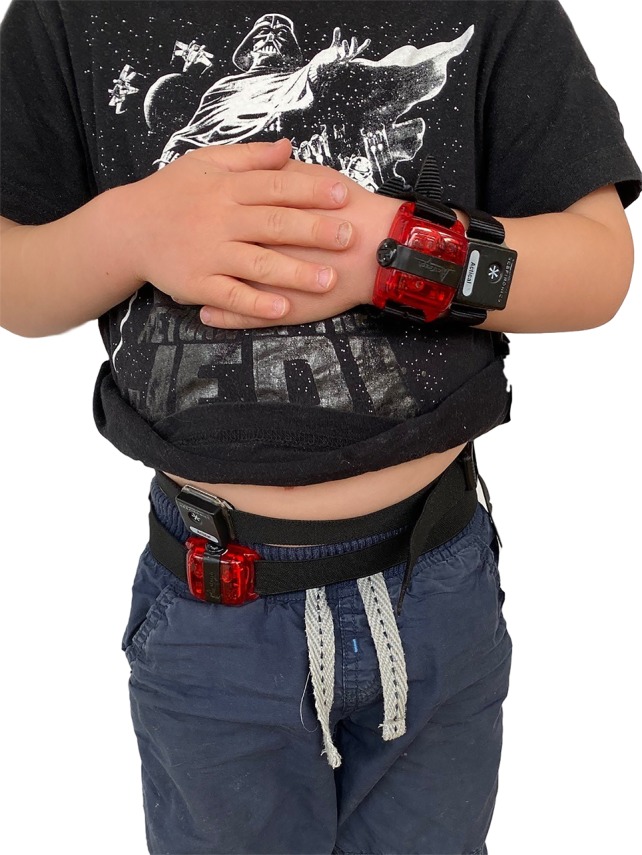
Site placements for wrist and waist worn ActiGraph GT3X+ and Actical accelerometers.